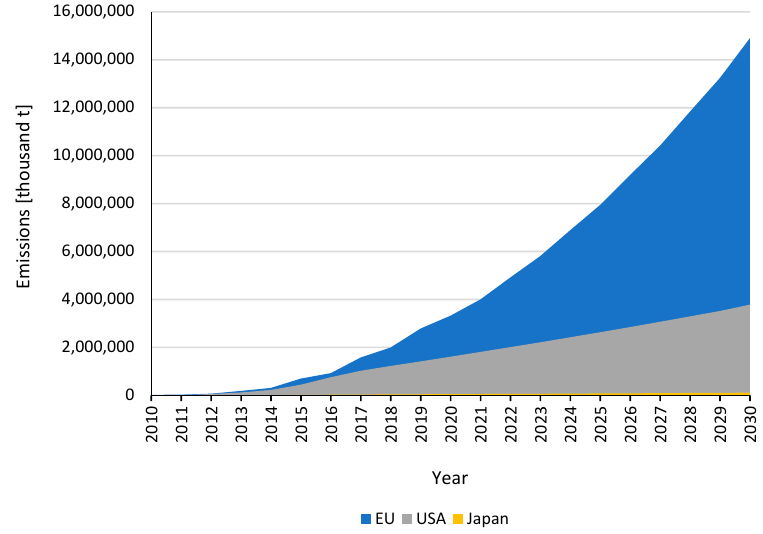
Figure 7. Well-to-wheel avoided CO 2 emissions (adjusted) with forecast for the EU, US and Japan.